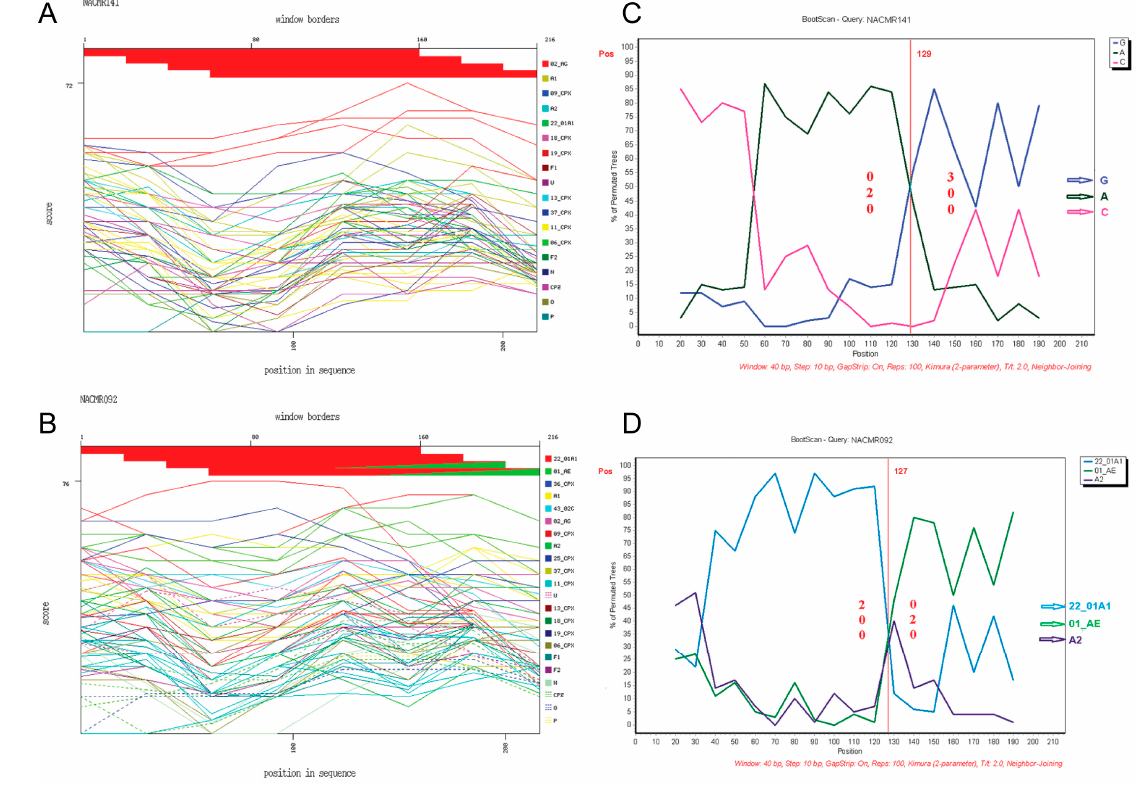
Figure 2. Recombination events identified and breakpoint prediction. Data show representative Tat exon-1 sequences from: a subject infected with HIV-1 CRF02_AG (NACMR141) ( A , C ); and a subject infected with CRF01_AE/CRF22_01A1 (NACMR092) ( B , D ). These clinical viral strains were genotyped using the NCBI retroviruses genotypes tool and reference subtypes (A1, A2, F1, F2, CRF02_AG, 43_02G, 01_AE, 22_01A1, 06_cpx, 09_cpx, 11_cpx, 13_cpx, 18_cpx, 19_cpx, 25_cpx, 36_cpx, 37_cpx, U (unclassified), HIV-1 groups N, O, P, and SIVcpz). For panels A and B , the red line represents CRF02_AG ( A ) or CRF22_01A1 ( B ) subtypes; and the green line represents CRF01_AE ( B ). For breakpoint prediction, bootscan analysis was performed using consensus sequences for subtypes G, A, C (panel C , blue, green and pink colors, respectively), or CRF22_01A1, CRF01_AE, and A2 (panel D , blue, green and purple colors, respectively). For all panels, the X-axis represents the percentage of sequence similarity to the corresponding subtype and the Y-axis represents the aa position of the sample sequenced.